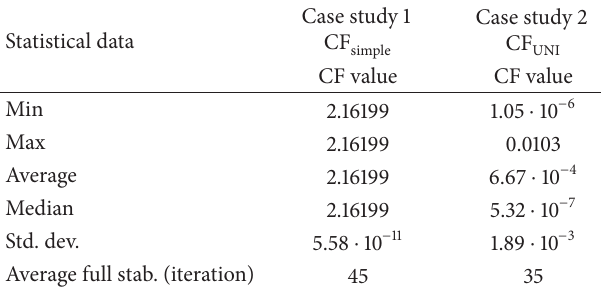
Table 4: Simple CF statistics: joined case studies 1 and 2, Burgers map as CPRNG/controlled system.